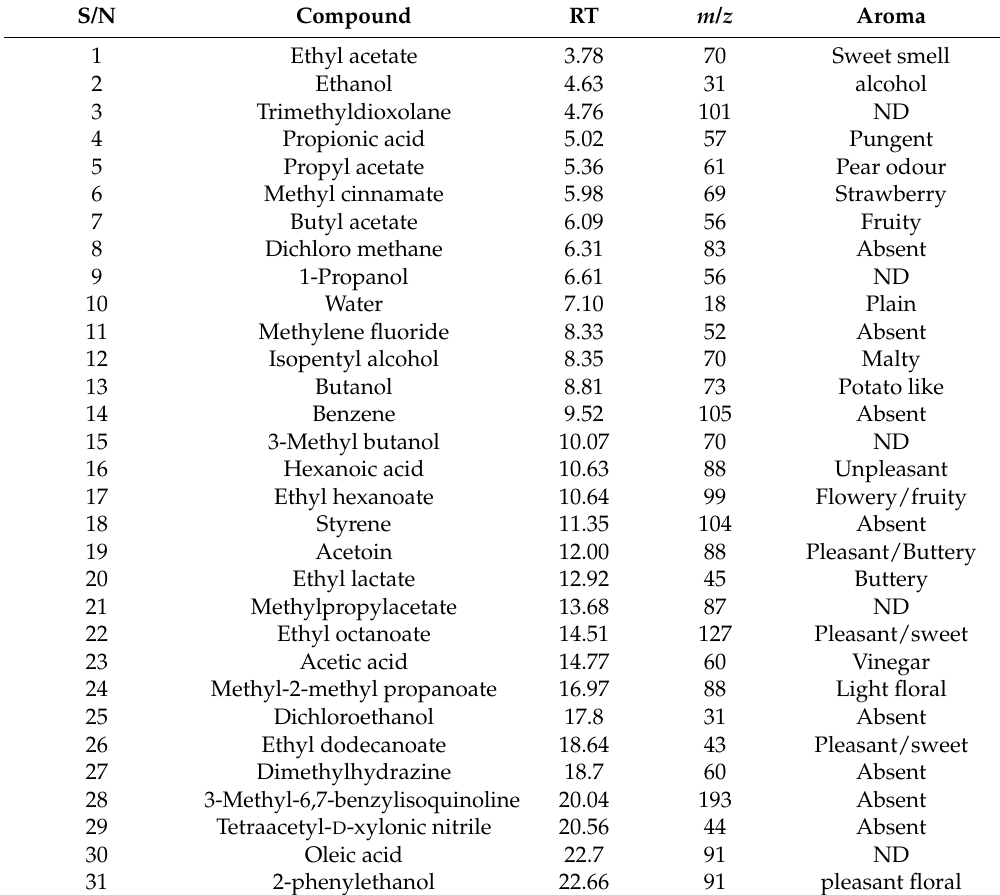
Table 2. Retention time (RT), mass to charge ratio ( m / z ) and the aroma described for detected products (ND = Aroma not described).